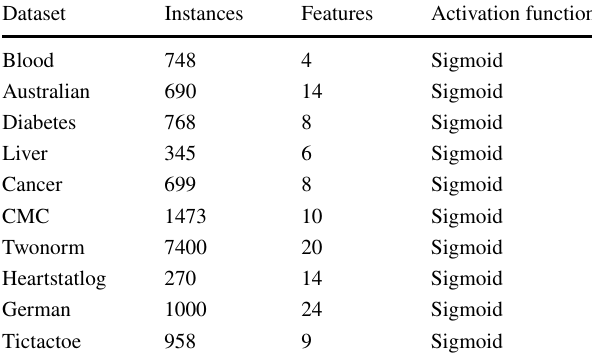
Table 1 Parameters of the algorithm Algorithm